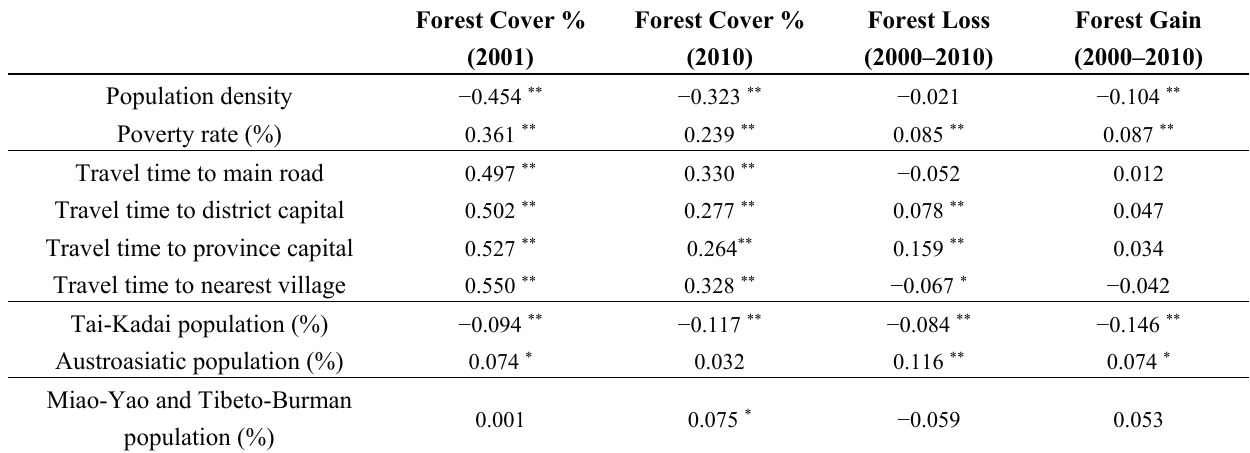
Figure 8. Forest cover change rate in relation with socio-economic variables in the Luang Prabang province (LPP). Table 8. Pearson correlations between forest cover change and socio-economic variables in the Luang Prabang